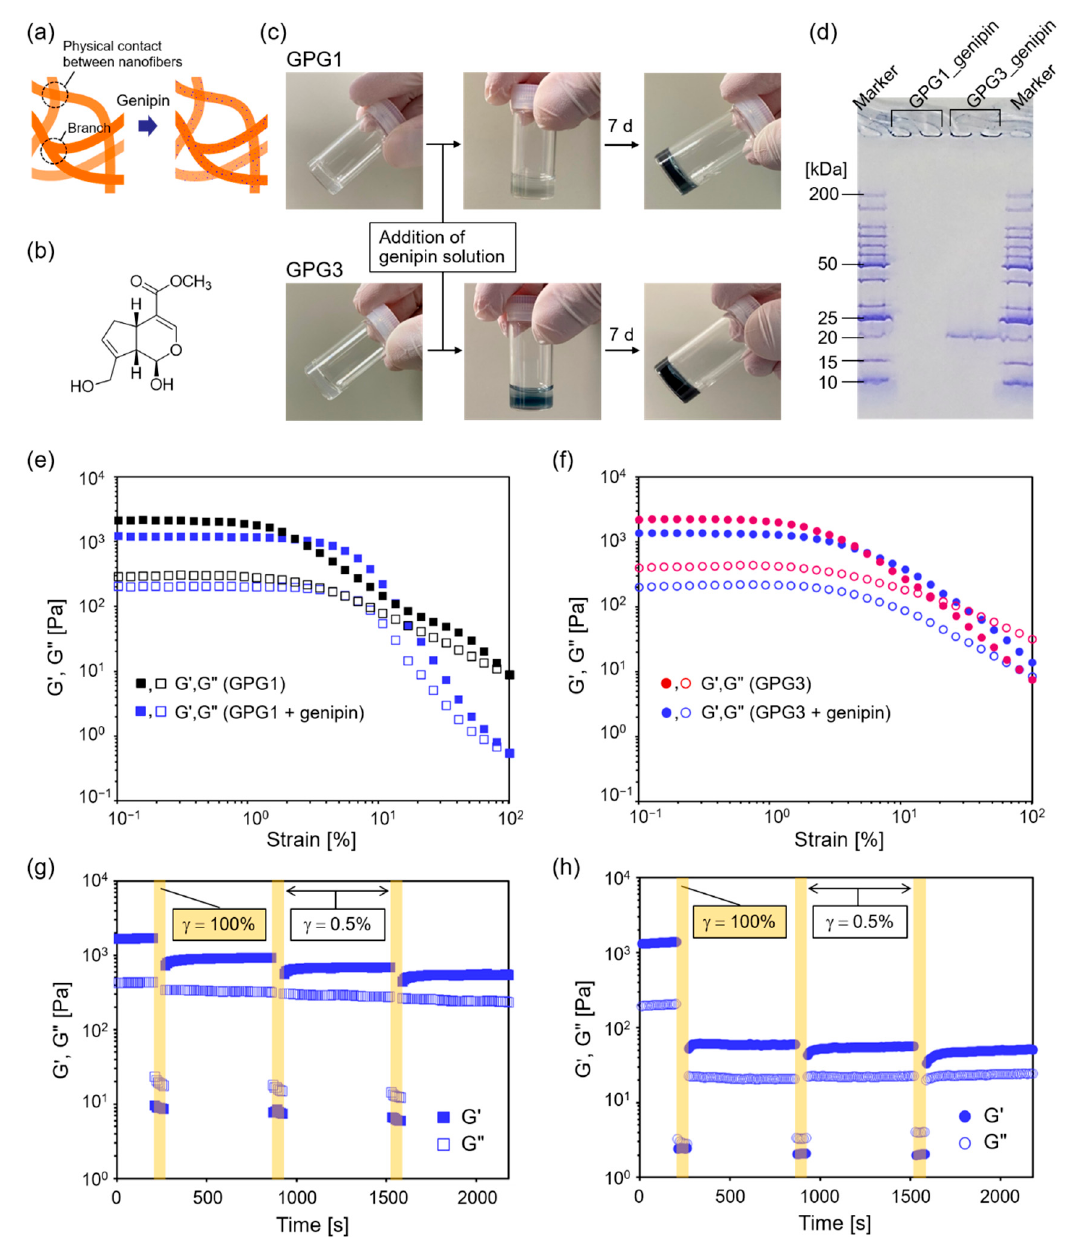
Figure 6. ( a ) Schematics of the chemical crosslinking of GPG nanofibers. ( b ) Chemical structure of genipin. ( c ) Change in the appearance of hydrogels by the addition of genipin solution. The supernatant solutions were removed in the photographs at 7 d. ( d ) SDS–PAGE of GPG1 and GPG3 gels after reacting with genipin for 7 d. ( e , f ) Effects of genipin crosslinking on the rheological properties of hydrogels containing ( e ) GPG1 and ( f ) GPG3 nanofibers at 0.5 wt% as a function of strain. The moduli of GPG1 gel at 1 d and GPG3 gel at 7 d in Figure 3a are re-plotted as references. ( g , h ) step-strain sweep measurements of ( g ) GPG1 and ( h ) GPG3 gels after genipin treatment.